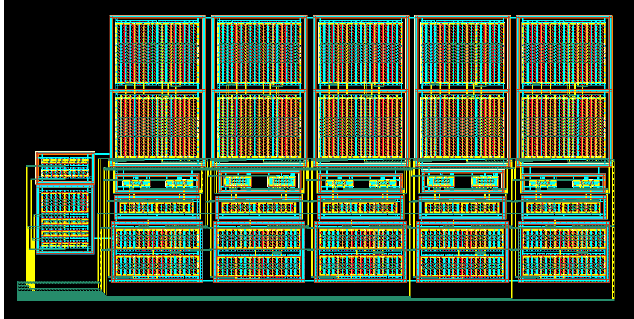
Figure 11. Layout of the fractional-order integrator of